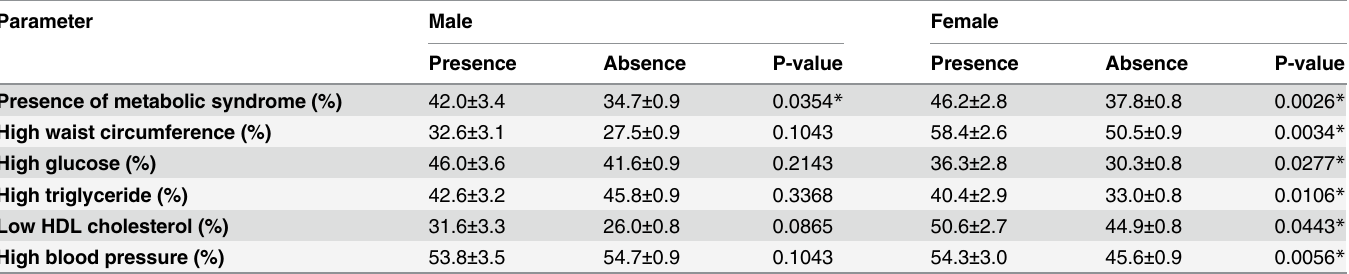
Table 2. Prevalence of metabolic syndrome and its components according to the presence or absence of olfactory dysfunction by gender. Parameter